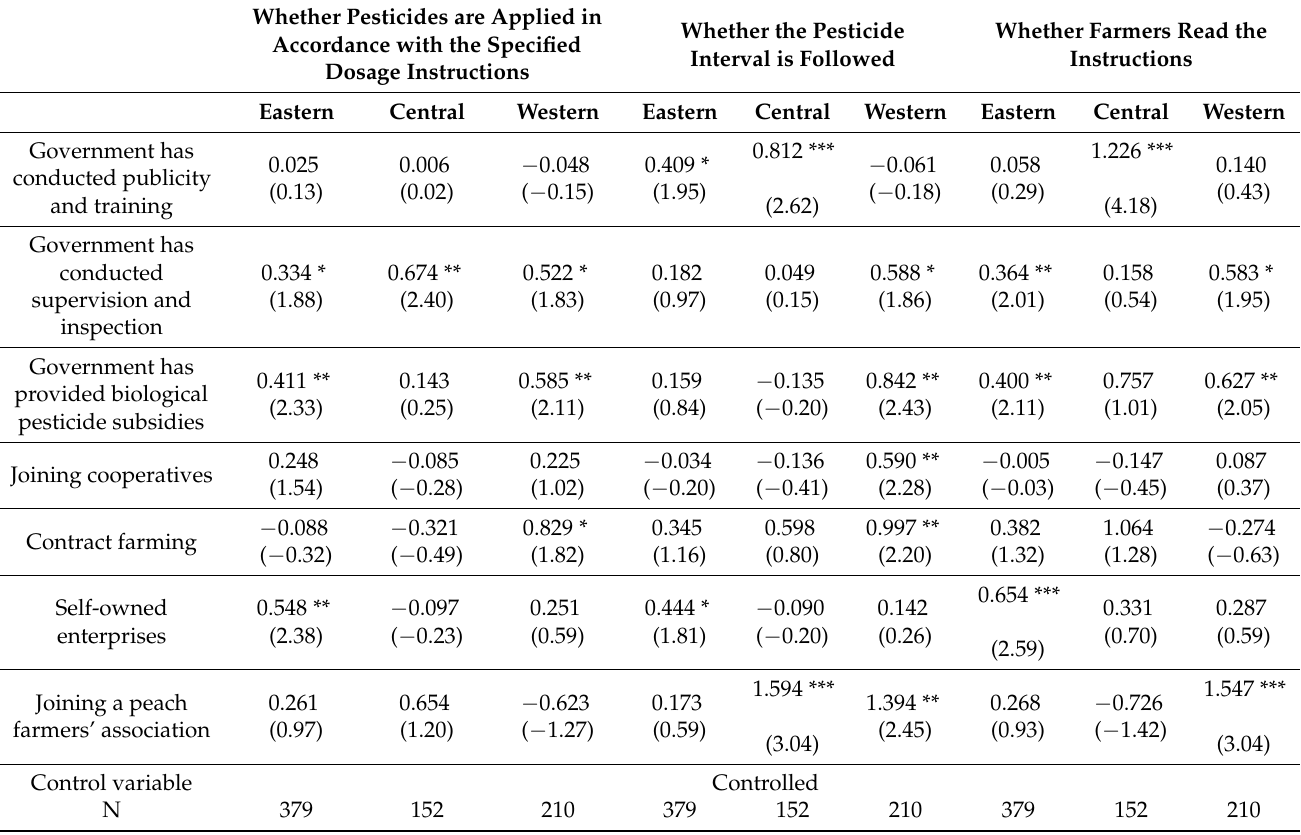
Table 7. The regression results of the peach farmer model in the eastern, central, and western